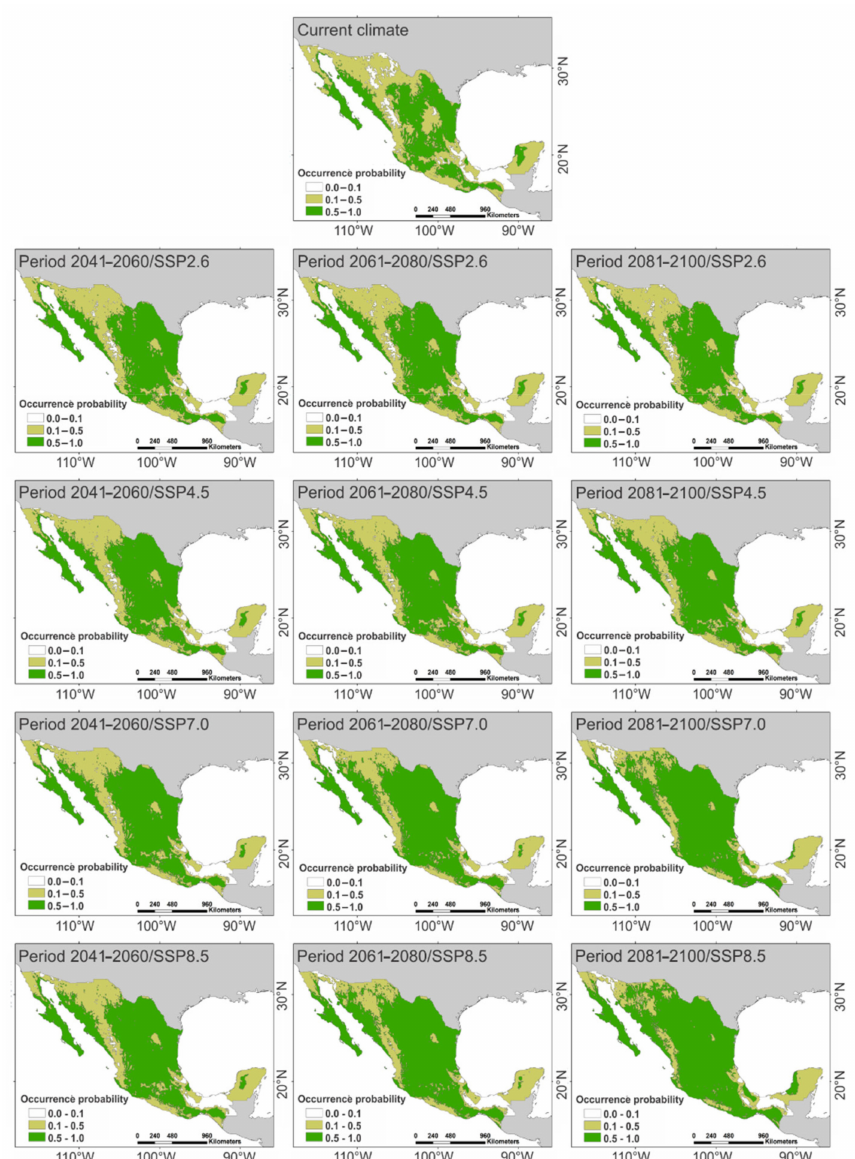
Figure 2. Distribution of suitable and unsuitable habitats for buffelgrass under the current and climate change scenarios. Occurrence probabilities below 0.1 are considered unsuitable, values between